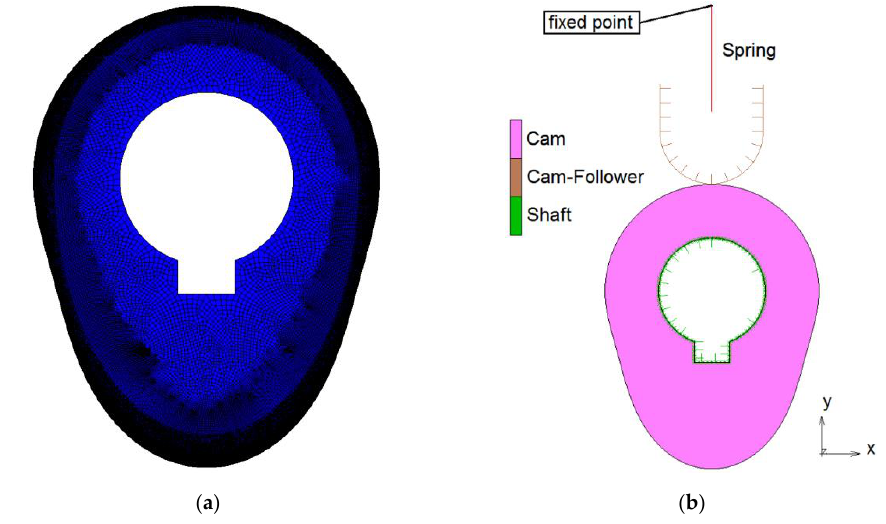
Figure 10. ( a ) Meshing of the cam and ( b ) contact bodies.